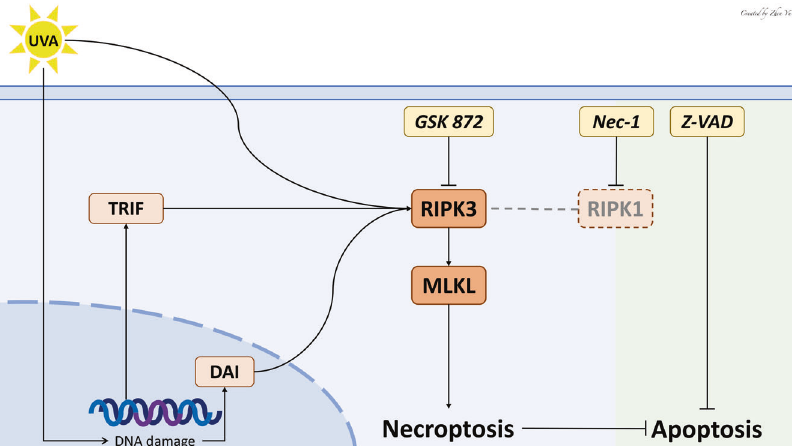
Fig. 6 Schematic summary for the present study. UVA-induced DNA damage leads to RIPK3 activation through the TRIF and DAI signal responses. RIPK3 but not RIPK1 in turn induces necroptosis by upregulation of MLKL expression and suppresses apoptosis by downregulation of GSK 872 (RIPK3 inhibitor) also can positively regulate UVA-induced necroptosis, while Nec-1 (RIPK1 inhibitor) and Z-VAD (apoptosis inhibitor)